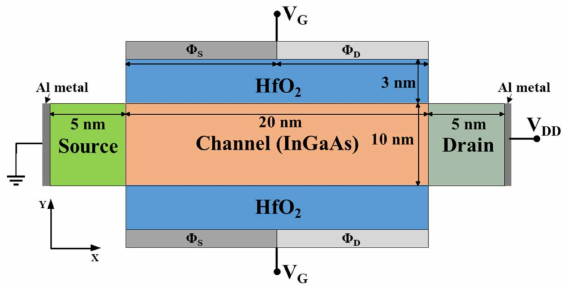
Figure 1. Schematic structure of the proposed double gate p-InGaAs TFET device.